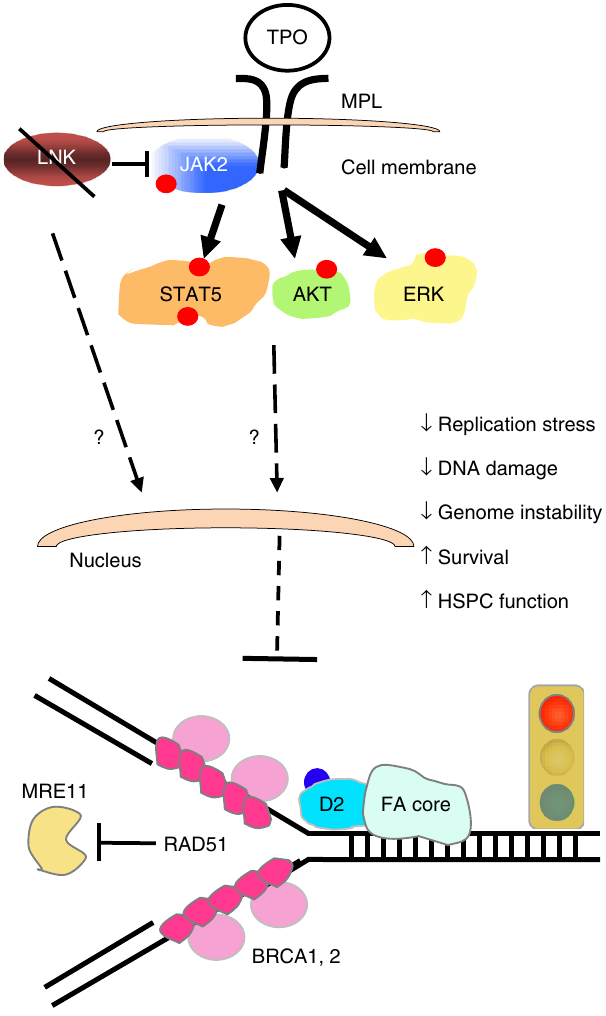
Fig. 8 Working model of how LNK signaling regulates replication stress and restores HSPC function in